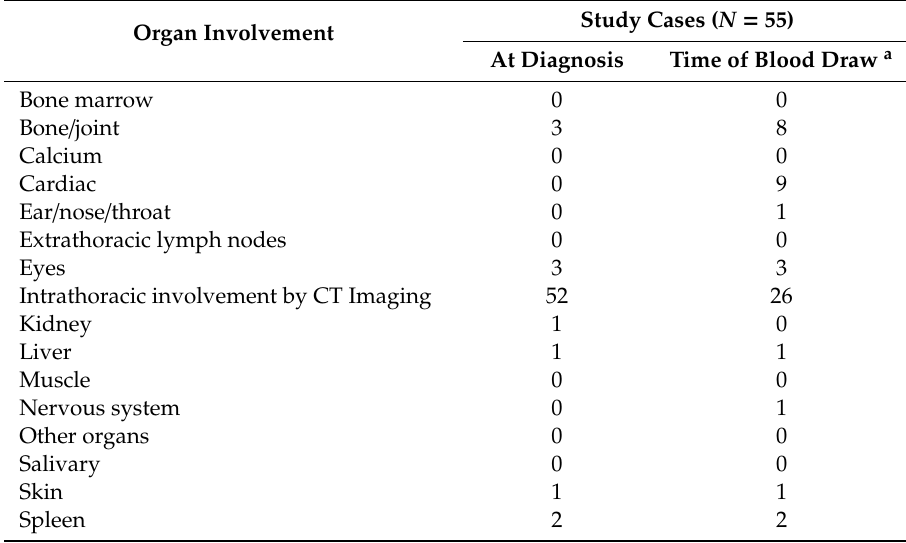
Table 2. Sarcoidosis organ involvement in WTC genetics study